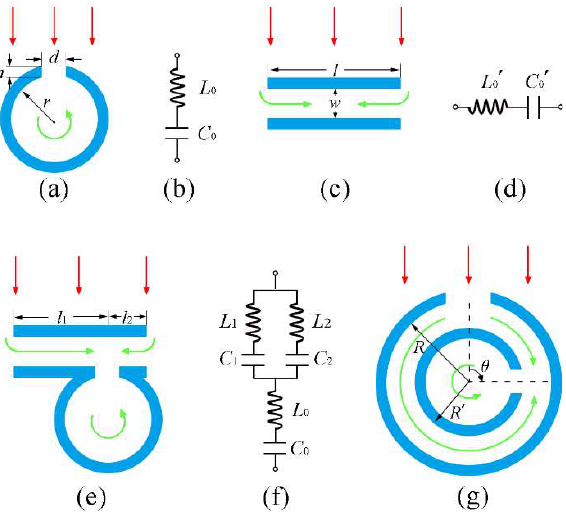
Figure 1. ( a ) and ( b ) Schematic sketch and equivalent circuit of the acoustic split hollow sphere (SHS). ( c ) and ( d ) Schematic sketch and equivalent circuit of the acoustic hollow tube (HT). ( e ) and ( f ) Schematic sketch and equivalent circuit of the coupled structure by SHS and HT. ( g ) Schematic sketch of the optimised model based on ( e ), the inner ring can be spun freely to arbitrary angle θ around its centre axis. All the blue areas indicate the acoustic rigid material, and the white areas are filled with air medium. The red arrows denote the incident waves. The green arrows indicate the schematic path of sound waves through the structures.